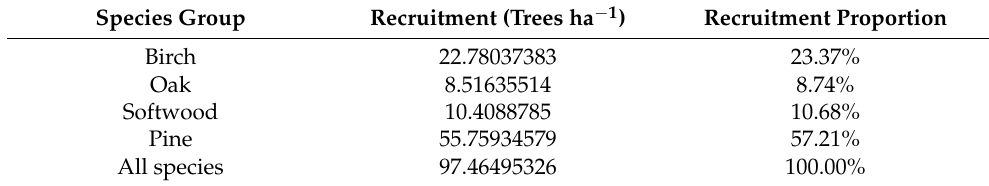
Table A5. Recruitment of trees for each species group in the first